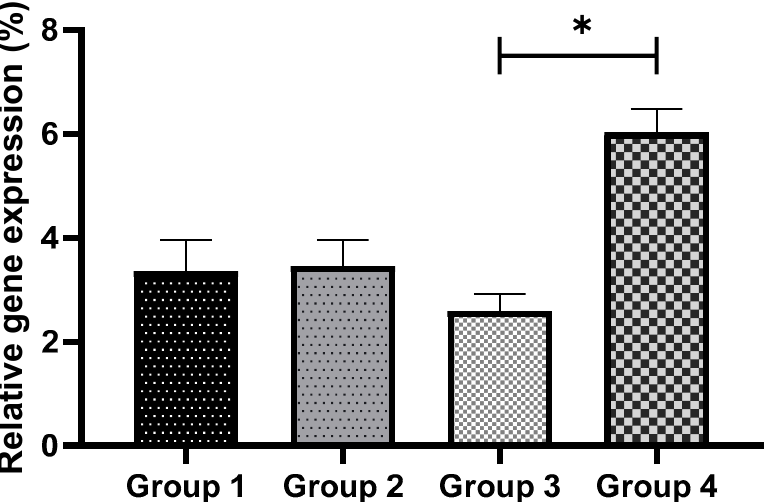
Figure 12. The effect of GSH supplementation on Sod1 gene expression in non-vitrified and vitrified groups. Data are expressed as the means ± SEM. * p < 0.05. Group 1 (GSH-free medium); Group 2 (GSH-supplemented medium); Group 3 (GSH-free medium with vitrification); Group 4 (GSH-supplemented medium with vitrification).